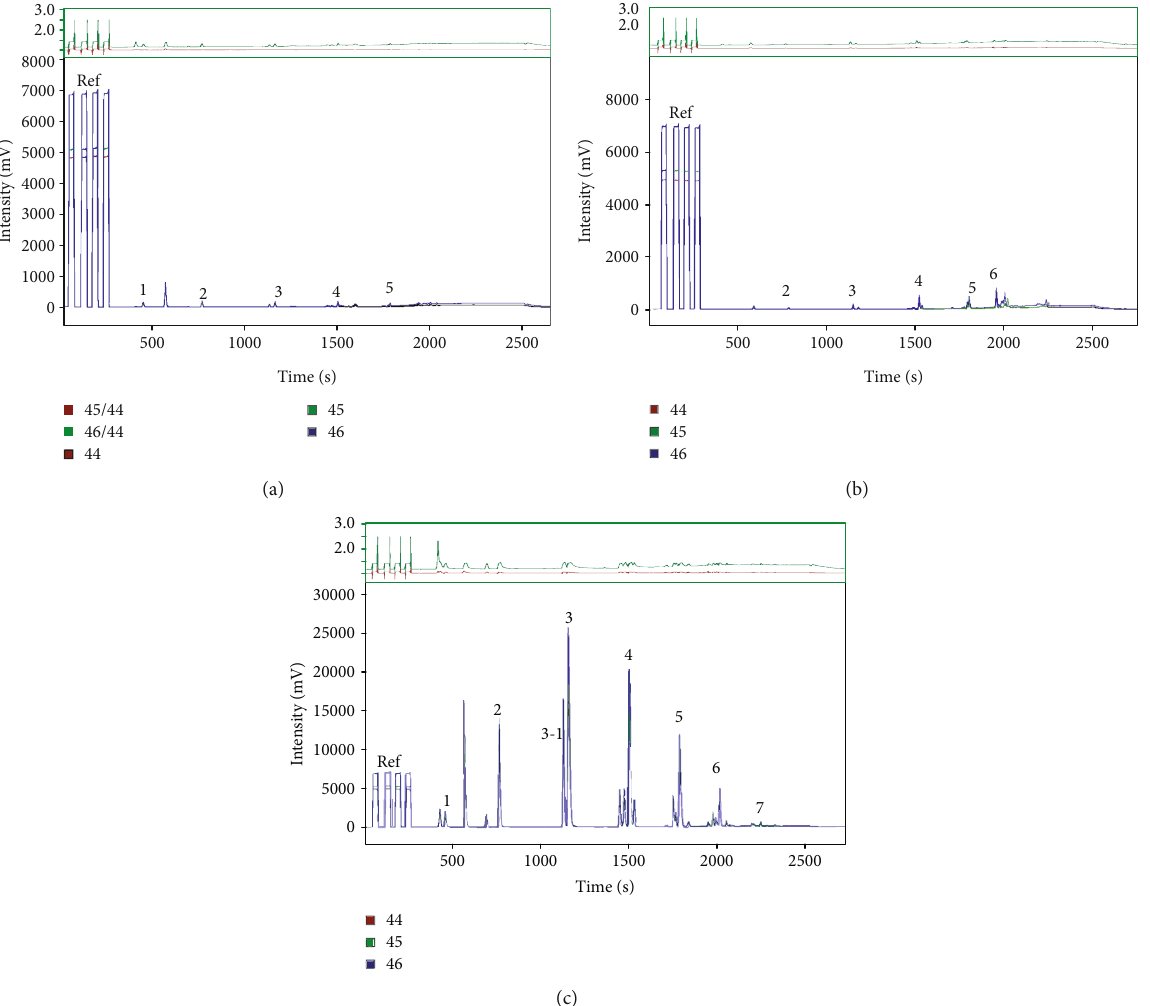
; 2: C H ; 3-1: C H ; 3: C H ; 4-1: 4 2 6 3 6 3 8